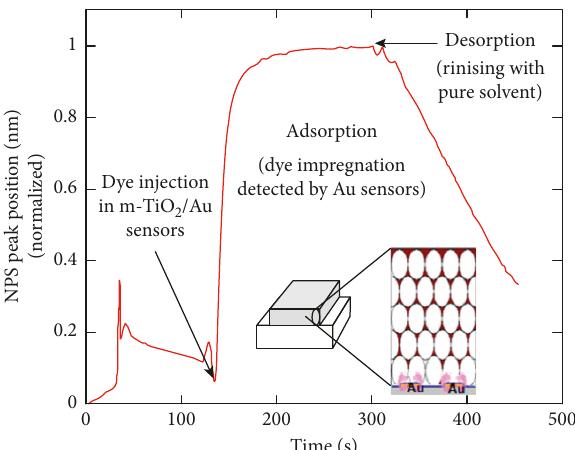
Figure 1: Nanoplasmonic response shows adsorption upon injection of dye into mesoporous titania on Au sensors followed by desorption upon rinsing with pure